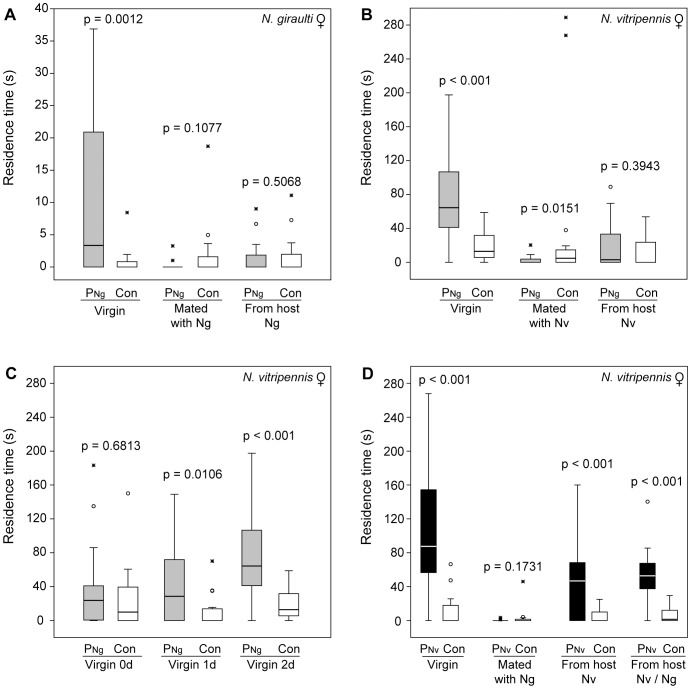
Pheromone response of Nasonia females in a two-choice olfactometer.Residence times of (A) Nasonia giraulti (Ng) and (B–D) N. vitripennis (Nv) females in the two odour fields of a static two-choice olfactometer (see also Figure S1) when given the choice between a solvent control (Con) and a pheromone extract (representing 100 ng total HDL) of either Ng (PNg, grey boxes) or Nv (PNv, black boxes) males. Tested females were either virgin, mated with a con- or heterospecific male under controlled conditions or collected in the moment of emergence from the host. Hosts were either infested by one species only (Ng, Nv) or multiparasitised by both species (Ng/Nv). Apart from panel (C), tested females were 1–2 days old. Box-and-whisker plots show median (horizontal line), 25–75 percent quartiles (box), maximum/minimum range (whiskers) and outliers (° >1.5× above box height; * >3× above box height) (data analysis by a Wilcoxon matched-pairs test; n = 20).